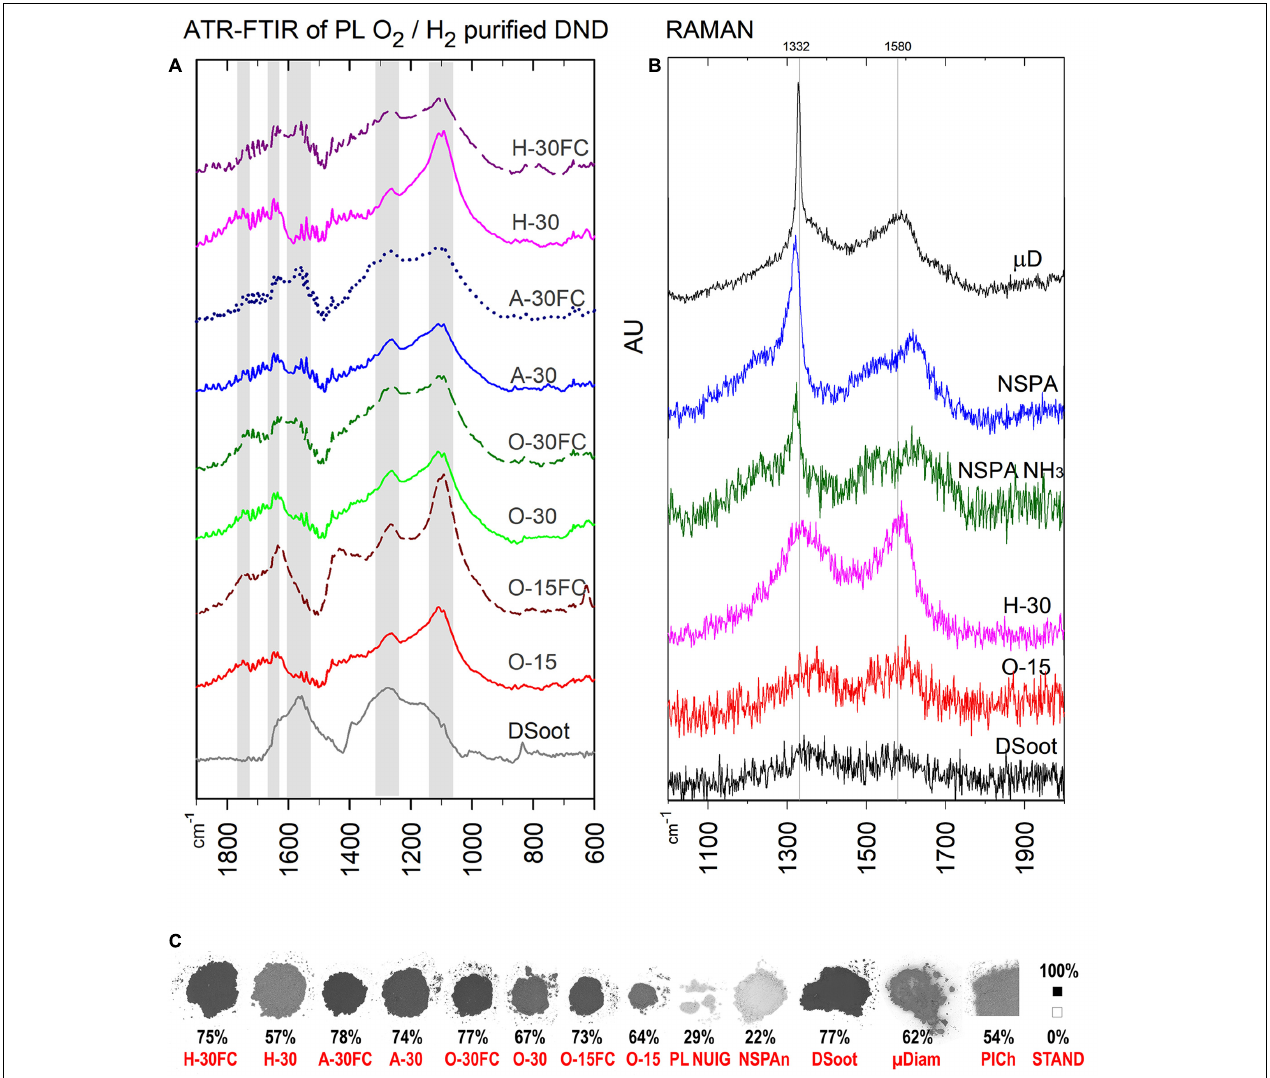
FIGURE 4 | ATR-FTIR (A) and Raman spectra of PL- and MW-treated DND (B) , as compared with the parent DS and HPHT micronsized diamond as a standard (Raman; the top). (C) B & W colour ratios for all plasma-purified DND, parent DS and several others (bottom; the percentage shows the relative darkness of the powder; far right: B & W standards, the black square is with the used 101 × 101 pixels sampling